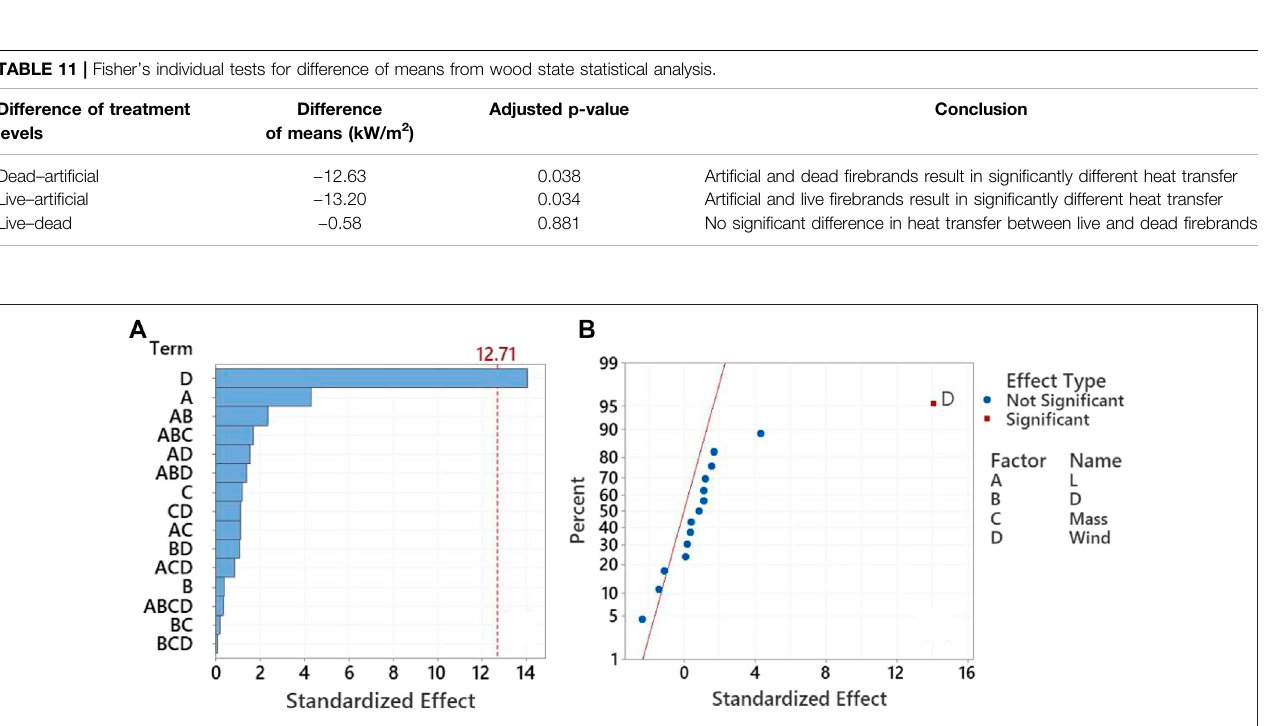
FIGURE 9 | Pareto chart (A) and normal plot (B) for the full factorial tests with all terms included.